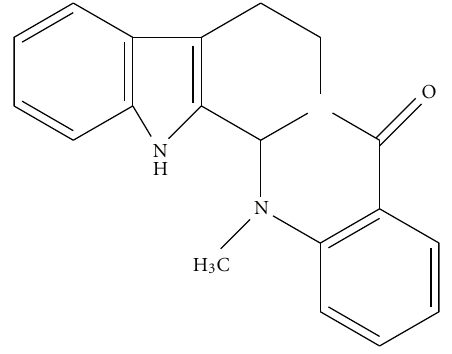
F 1: e structure of Evodiamine.